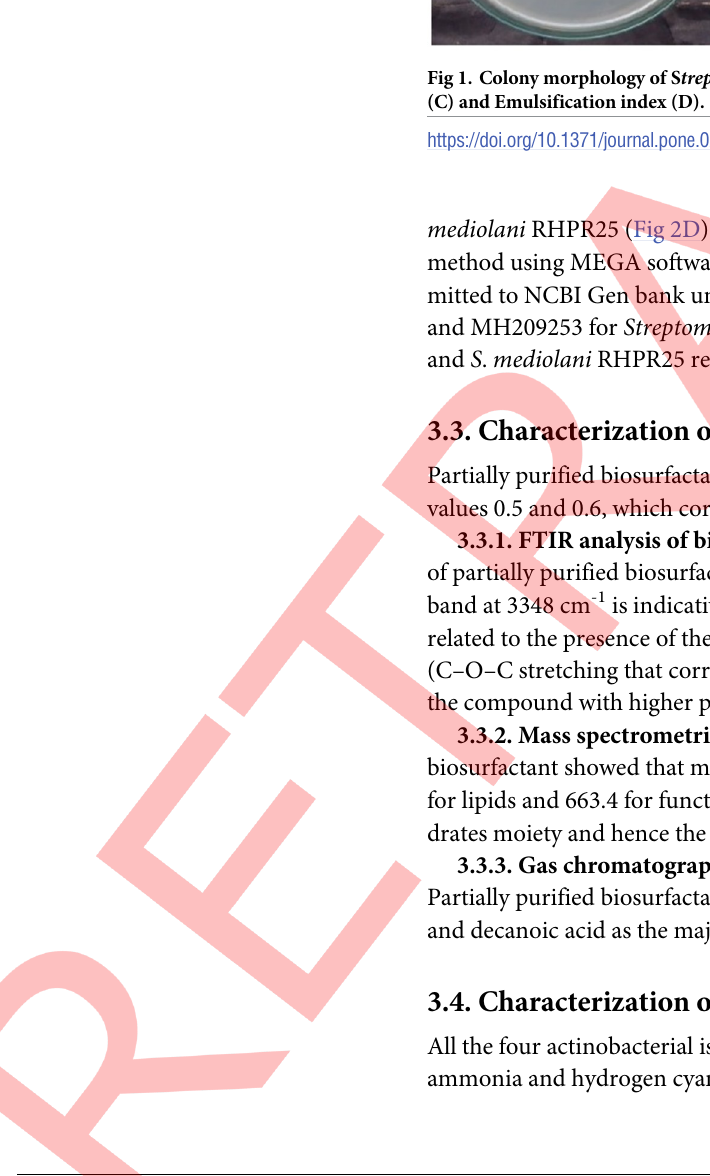
Fig 1. Colony morphology of S treptomyces puniceus RHPR9 (A) and Oil displacement method (B), Lipase activity (C) and Emulsification index